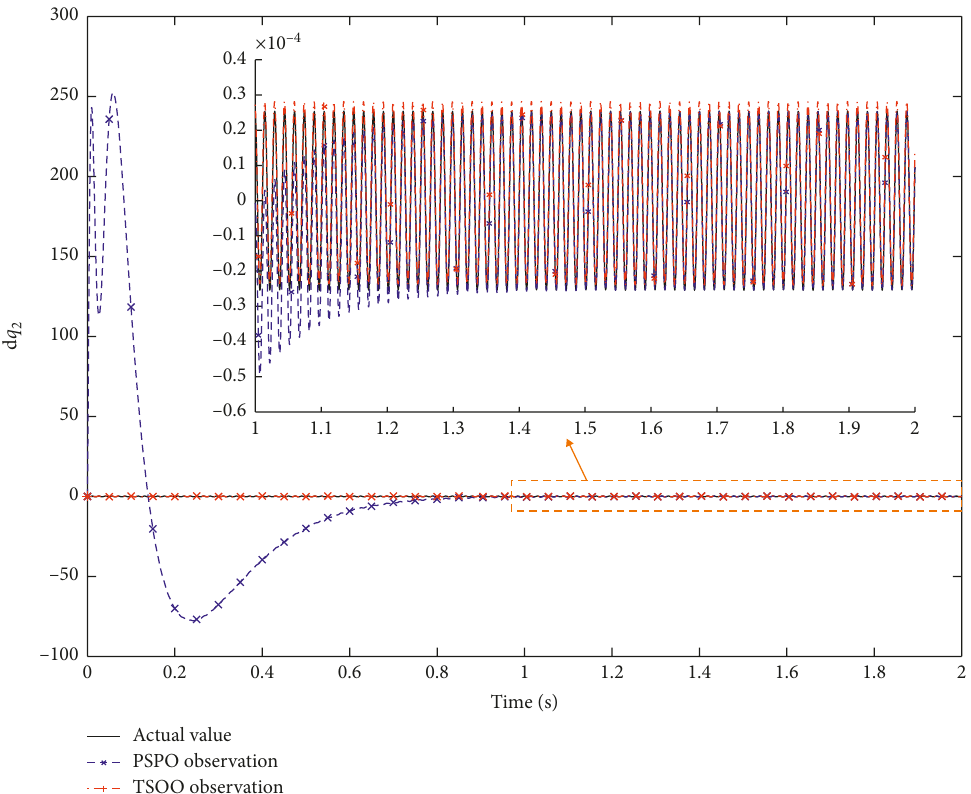
Figure 8: Observation effect comparison for the derivative of the second-order mode